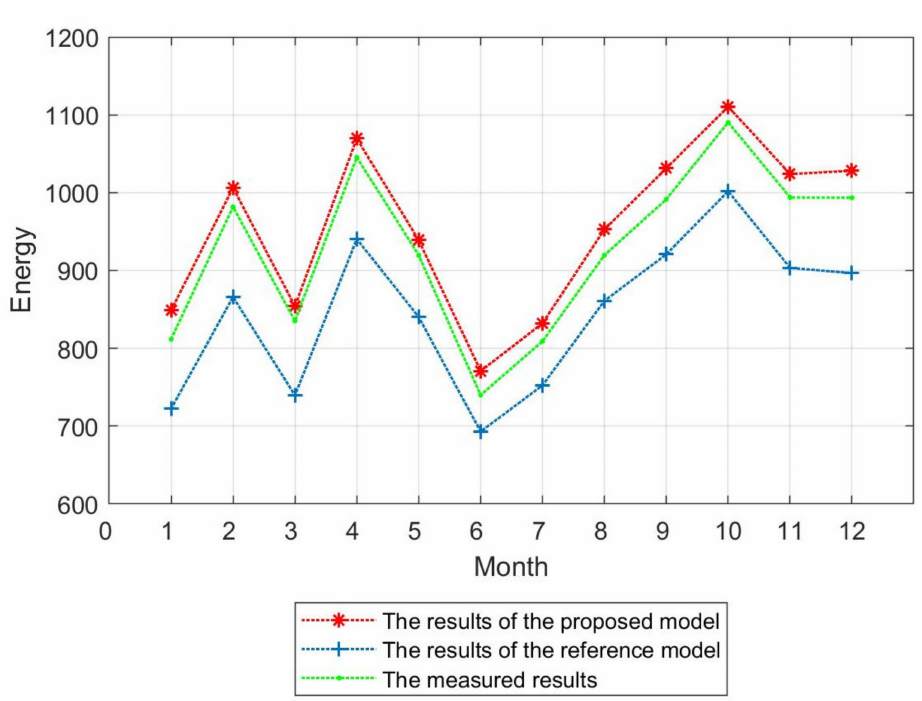
Figure 8. Monthly values of E